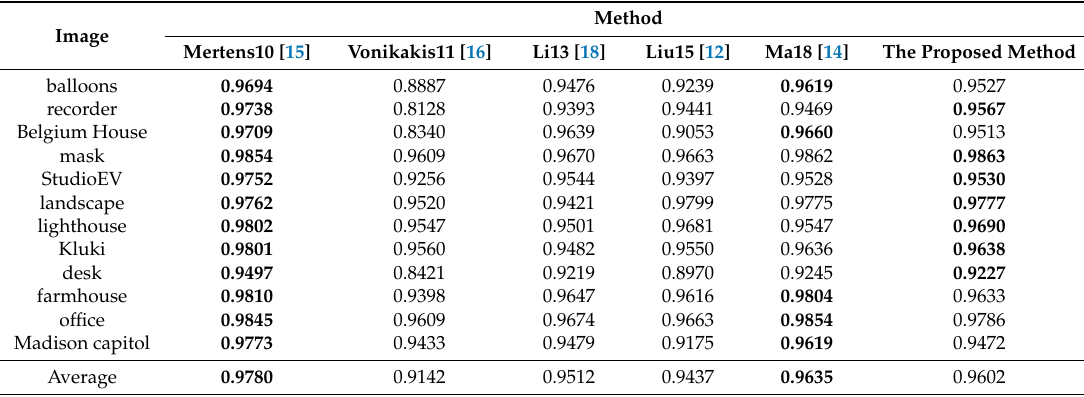
Table 2. Performance of different methods on the 12 image sequences, using the structural similarity index (MEF-SSIMc) [38]. Top two values are shown in